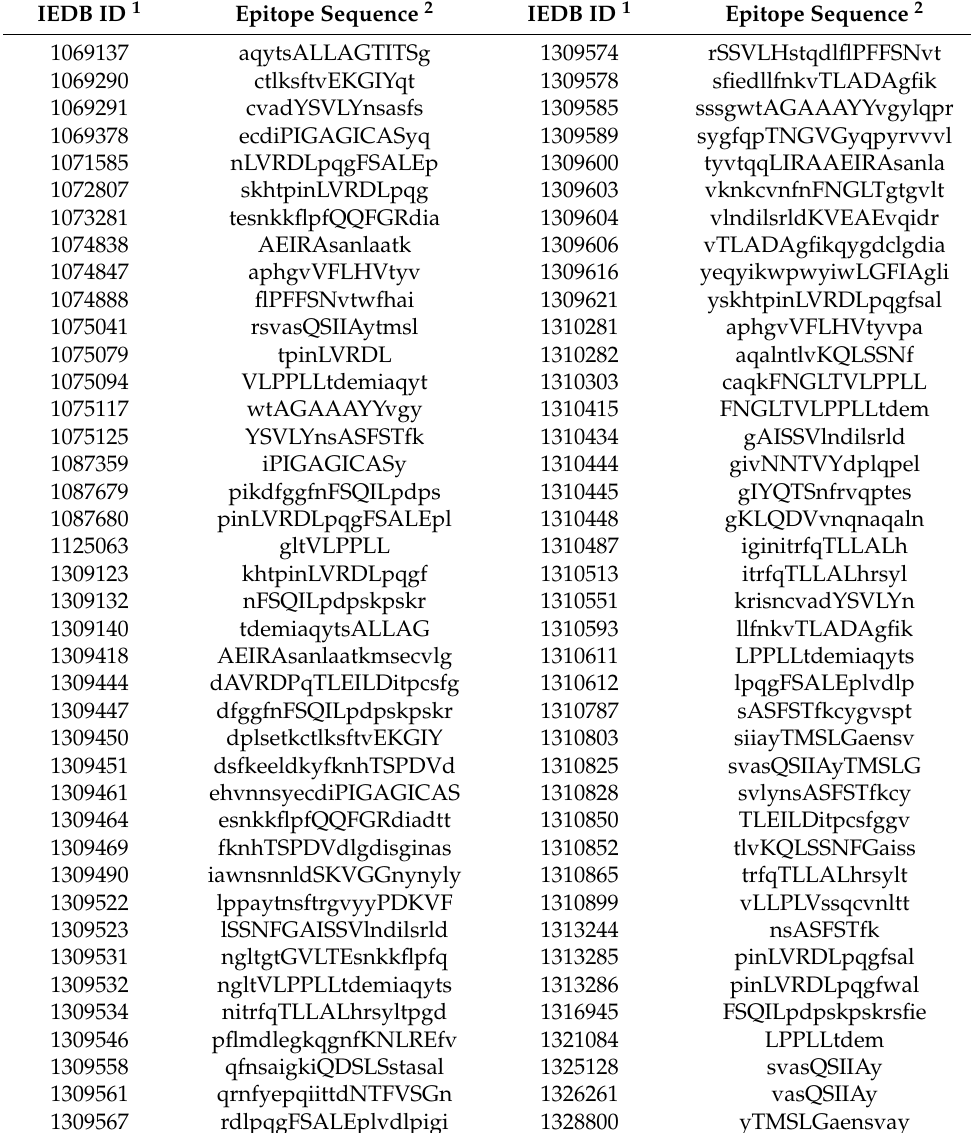
Table 3. Immunoreactive SARS-CoV-2 spike gp-derived epitopes containing peptides shared between the SARS-CoV-2 spike gp and anti-inflammatory human